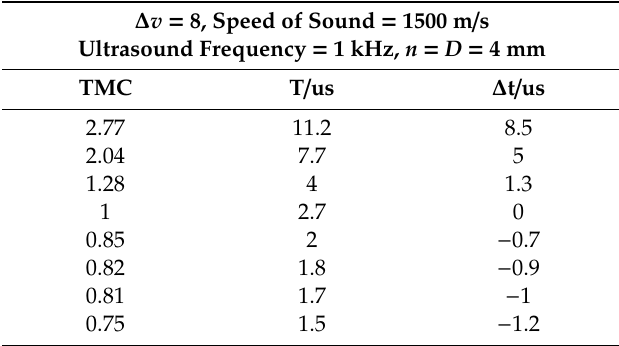
Table 6. Initial values when the surface